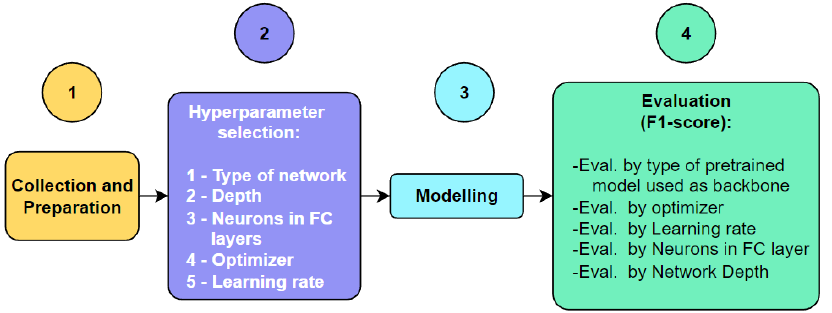
Figure 2. Proposed methodology for quantitative evaluation of coffee rust detection models using transfer learning.